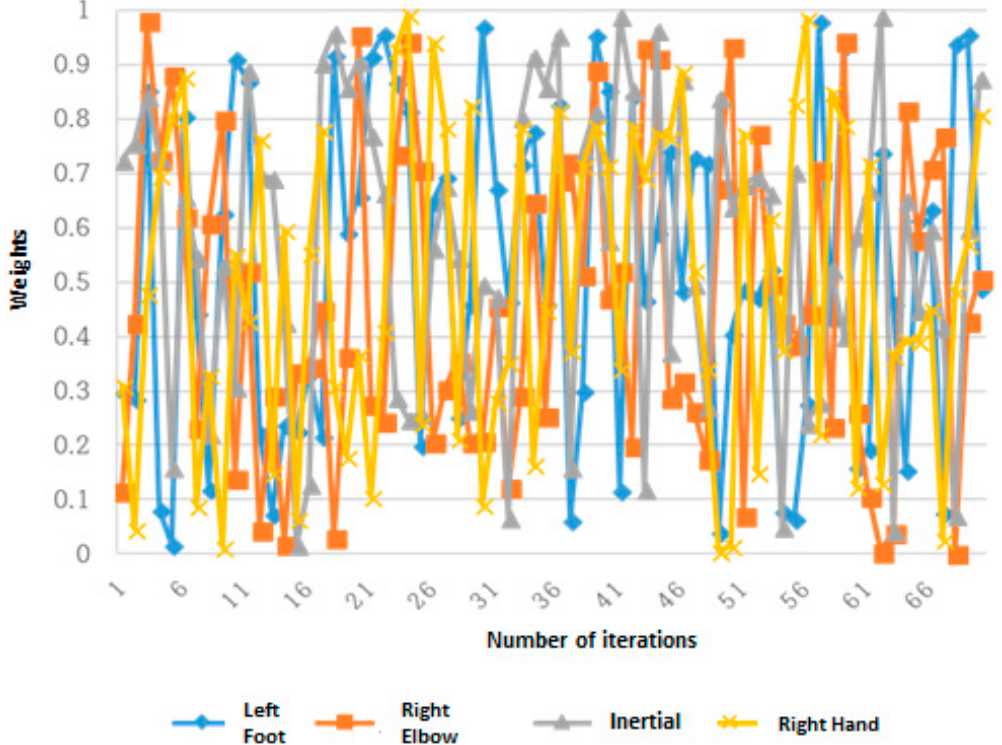
Figure 7. Weights of bowling motion set through the differential evolution method. Experimental Results for Bowling Action with Adjusted Weights by Differential Evolution Where ( 0.1 ≤ α ≤ 1 ).